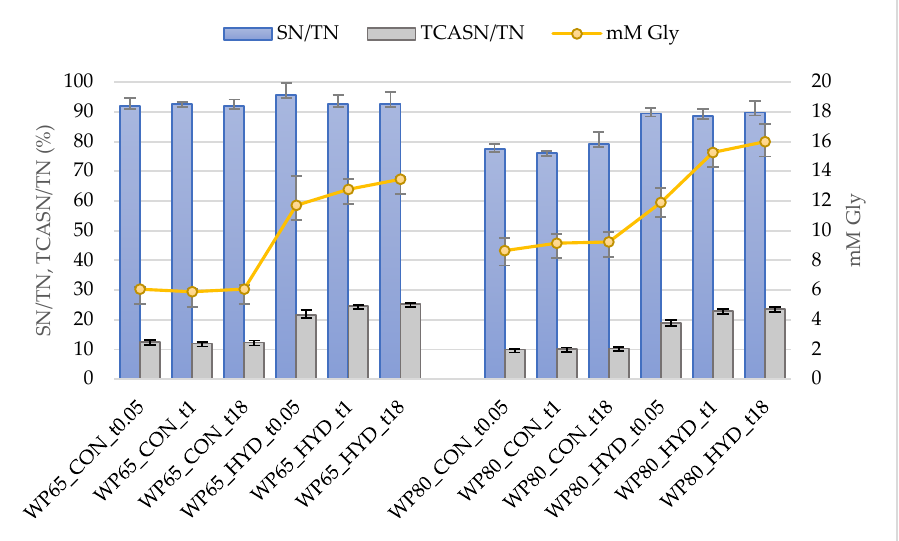
Figure 1. Proteolysis indices of tryptic hydrolysates of 5% ( w / w ) solutions of WPC powders of sheep/goat origin manufactured from Feta cheese whey in comparison to non-treated control coun- terparts. Abbreviations are explained in Table 1 and Section 2.2.1. Means and standard deviations of three experiments.